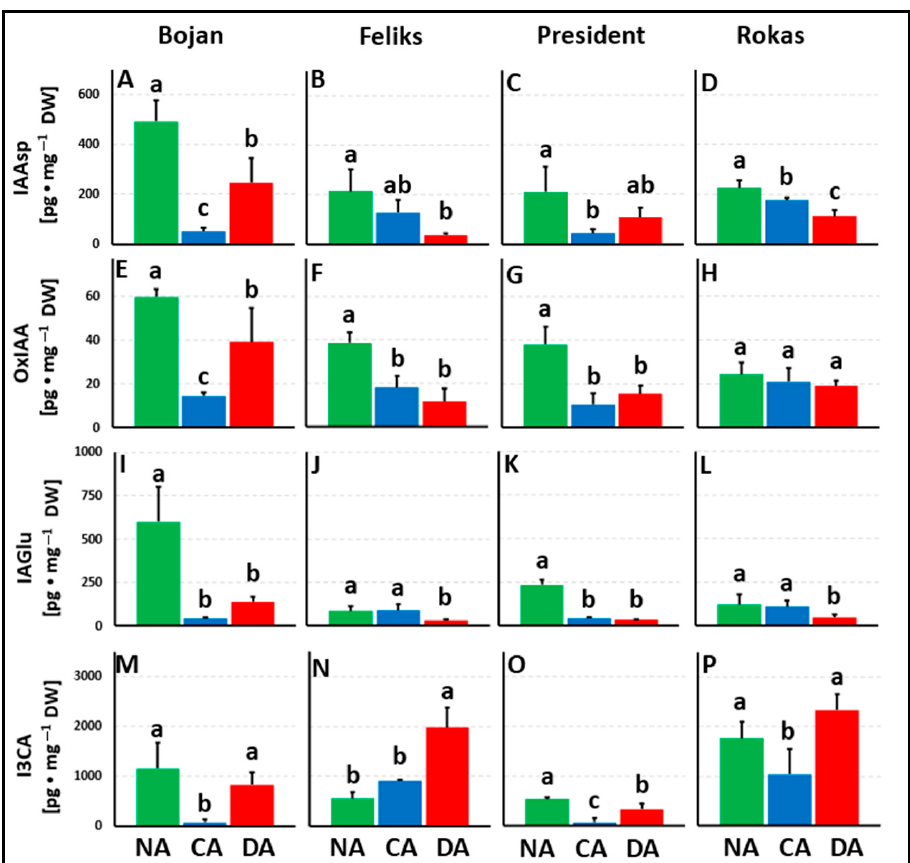
Figure 4. Content of the auxin precursors (indole-3-acetamid (IAM), indole-3-acetonitril (IAN)) and active auxin indole-3-acetic acid (IAA) in four cultivars of the non-acclimated (NA), cold-acclimated (CA) and deacclimated (DA) oilseed rape. ( A – D )—IAM; ( E – H )—IAN; ( I – L )—IAA. Values marked with the same letters (within each cultivar separately) were not significantly different according to the Duncan test ( p ≤ 0.05).